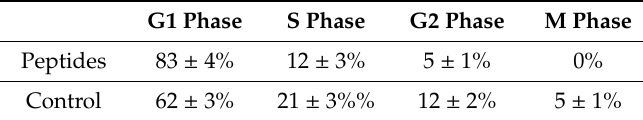
Table 2. Distribution of cells in the phases of the cell cycle.